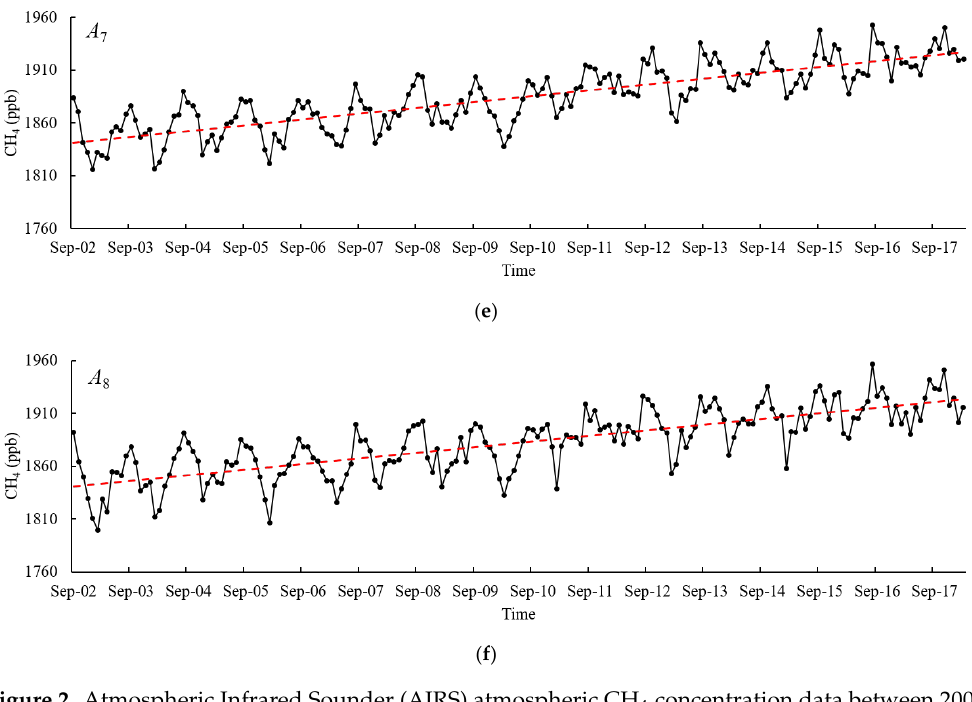
Figure 2. Atmospheric Infrared Sounder (AIRS) atmospheric CH 4 concentration data between 2002 and 2018, shown as a black curve. Each dot is an observation or one month in the monthly AIRS data. The red, dashed line is a linear fit line. ( a ) A 2 , ( b ) A 4 , ( c ) A 5 , ( d ) A 6 , ( e ) A 7 , and ( f ) A 8 . Table 2. Intercept and slope values of linear fit lines for A 2 , A 4 , A 5 , A 6 , A 7 , and A 8 .